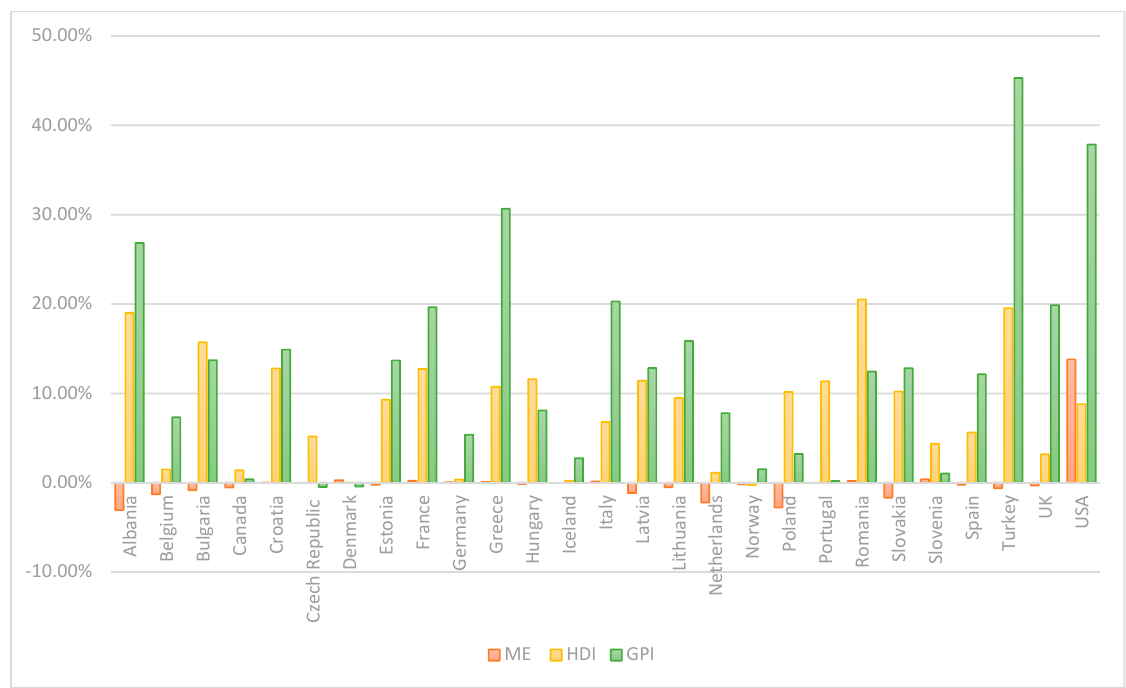
Figure 8. Situation of the countries with respect to their ε -efficient closest solution.